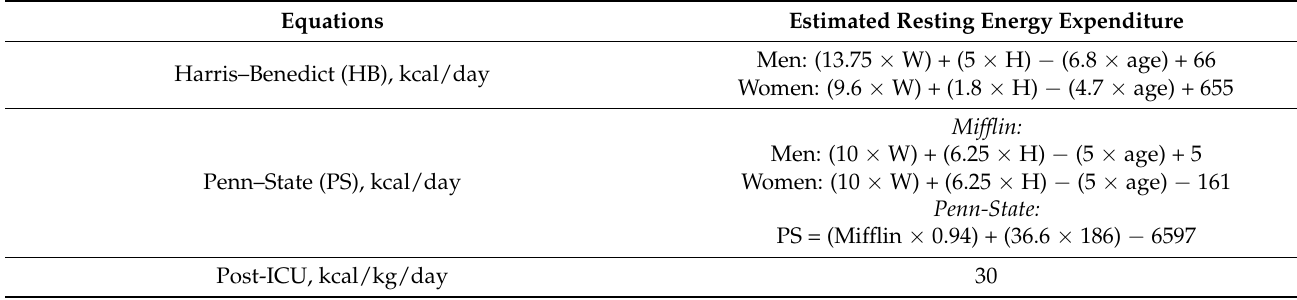
Table 1. Estimated energy needs: predictive equations. Equations Estimated Resting Energy Expenditure Harris–Benedict (HB),